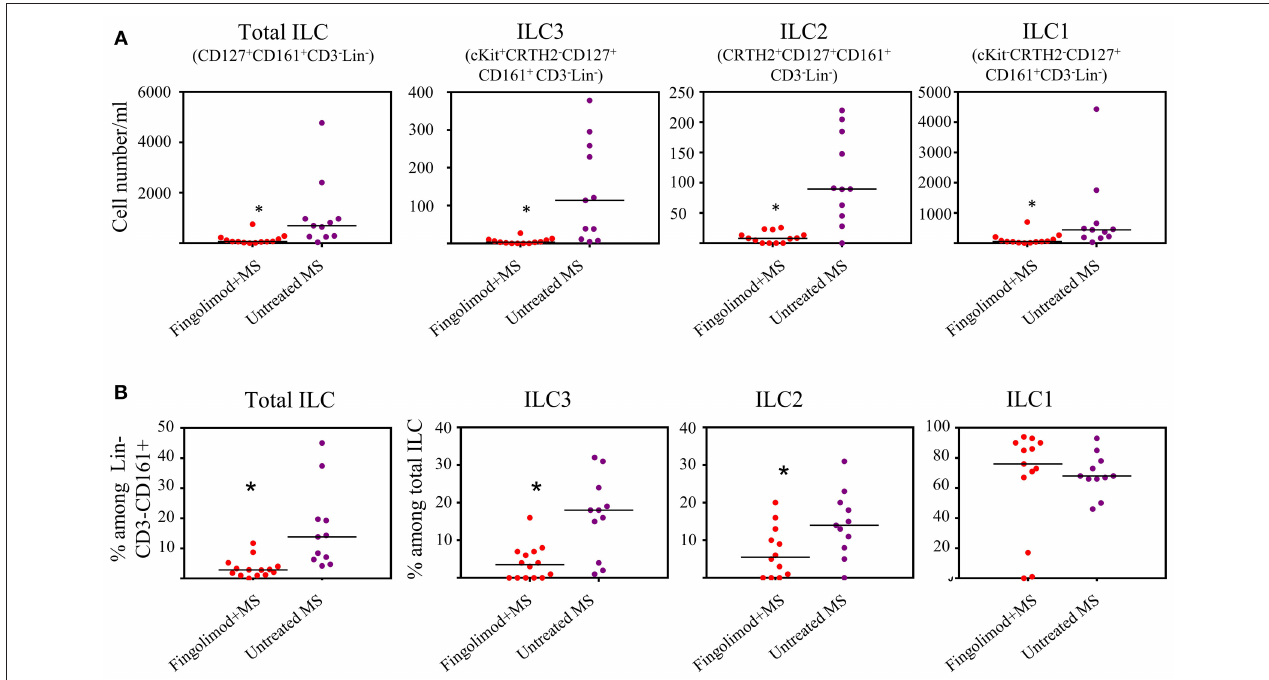
FIGURE 2 | Fingolimod causes ILC-penia in human peripheral blood. (A) absolute number of total or subsets of ILCs in the peripheral blood of MS patients treated with fingolimod ( n = 14) or untreated control MS patients ( n = 11) per 10ml peripheral blood. Total ILCs were gated as CD127 + CD161 + CD3 − Lin − cells, ILC3s as cKit + CRTH2 − CD127 + CD161 + CD3 − Lin − , ILC2s as CRTH2 + CD127 + CD161 + CD3 − Lin − , and ILC1s as cKit − CRTH2 − CD127 + CD161 + CD3 − Lin − . (B) percentages of ILCs in “A”. *Indicates p < 0.05.